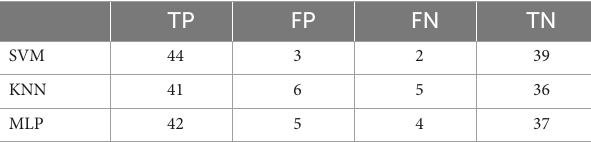
TABLE 4 Classification results by SVM, KNN, and MLP, using combined feature vectors. TP